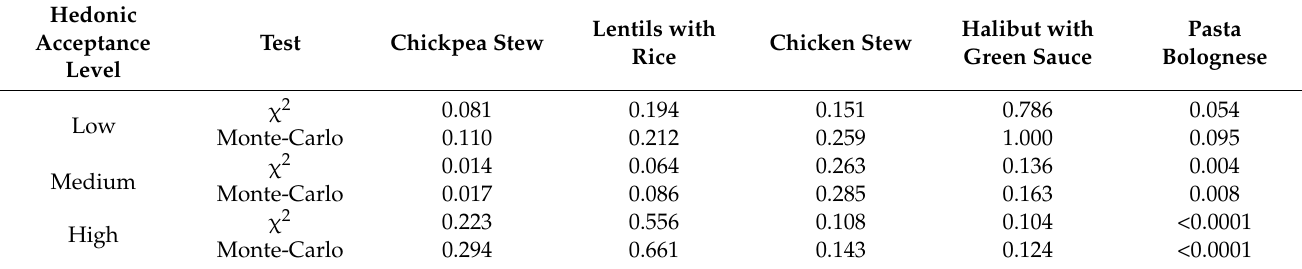
Table 2. Results of the Chi-square ( χ 2 ) and Monte-Carlo tests, according to the acceptance levels, to detect possible differences between the non-dysphagic and dysphagic